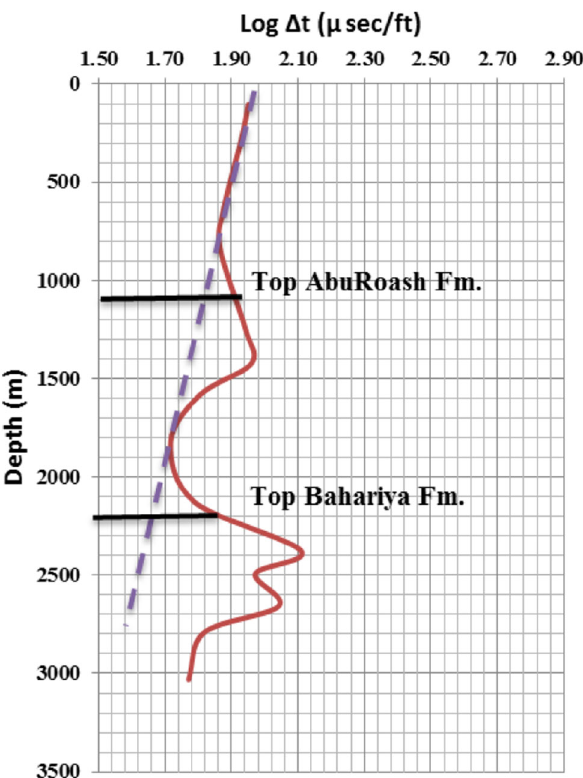
Fig. 7 Bulk densities from CDP 120 and from EBS-3X